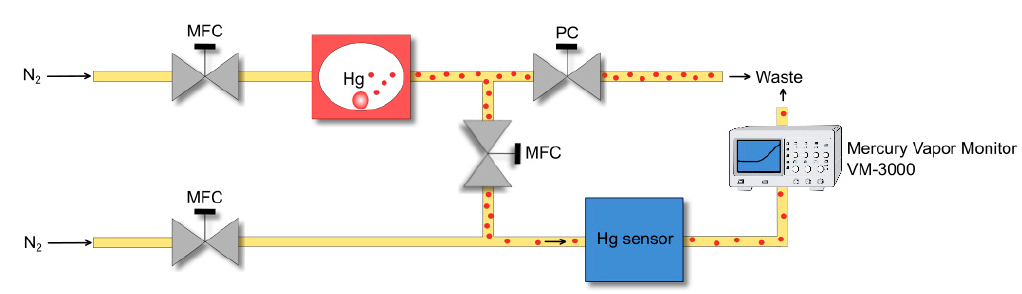
Figure 2. Pneumatic setup including mass flow controller (MFC) and pressure controller